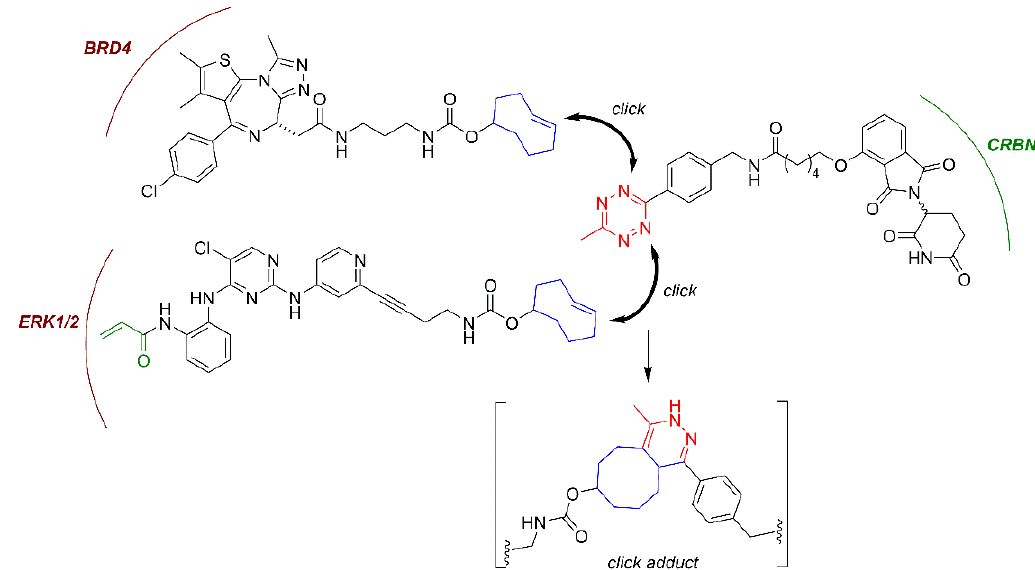
Figure 6. Design of cliptacs by the in-cell bioorthogonal click reaction of two smaller clickable partners. The moieties suitable for the click reaction are marked in blue and red, while the covalent warhead present in the ERK1/2 ligand is shown in green.